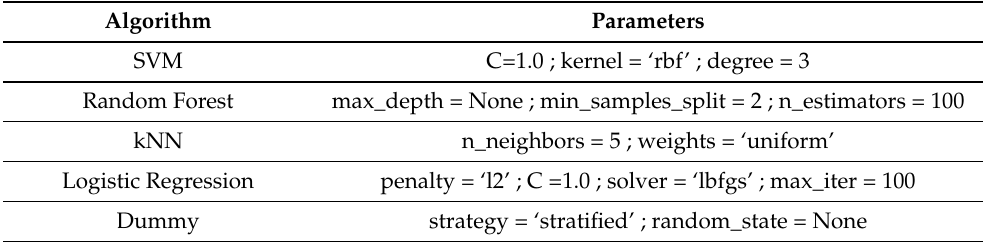
Table 1. Classification algorithms and respective parameters